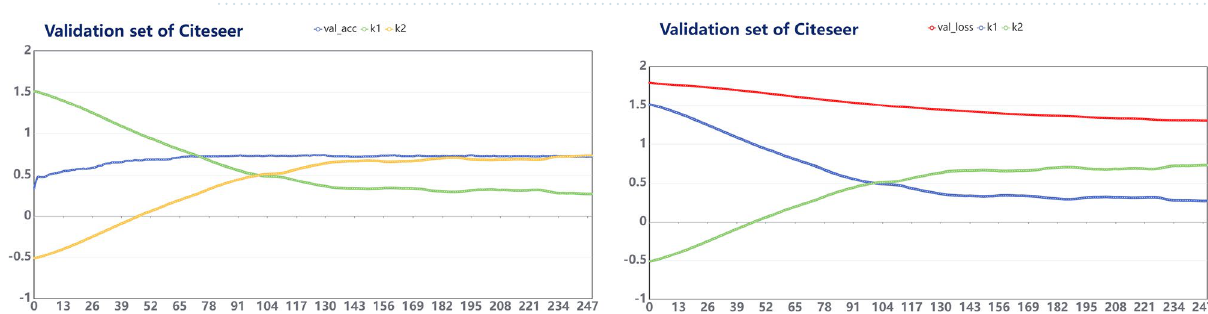
Figure 8. Citeseer: Fitting relationship between train_acc, train_loss and parameters.